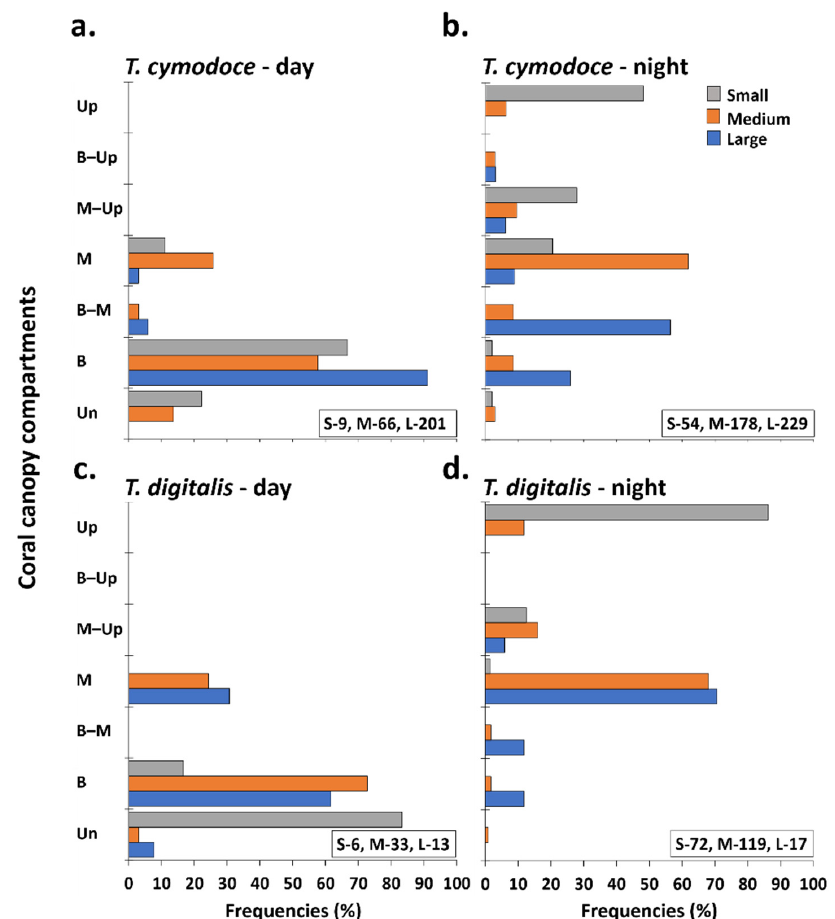
Figure 3. Trapezia’s different body sizes (small, medium, large) diel distributions among Stylophora pistillata (n = 193) canopy compartments recorded over two years under in situ surveys (2020–2021). Trapezia cymodoce ( a ) day and ( b ) night frequencies (%); and Trapezia digitalis ( c ) day and ( d ) night frequencies (%). Total observations by body size (L= large, M= medium, S= small) are marked for each plot. Frequencies were calculated according to the total abundance of each species group size for each day time census. (Un) understory; (B) base; (M) middle; (B ‐ Up) base, middle, and up; (M ‐ Up) middle and up compartments.